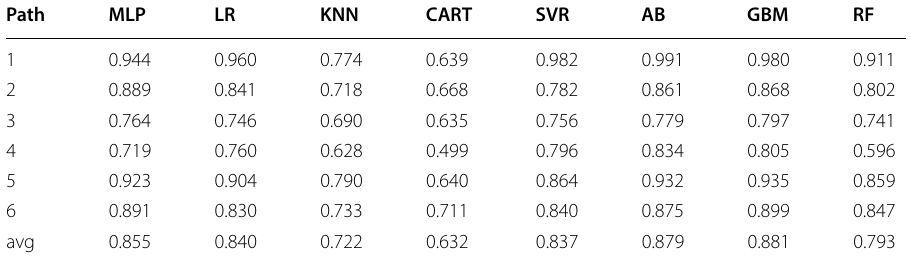
Table 2 Comparison among algorithms performances on the six driving cycles Path MLP LR KNN CART SVR AB